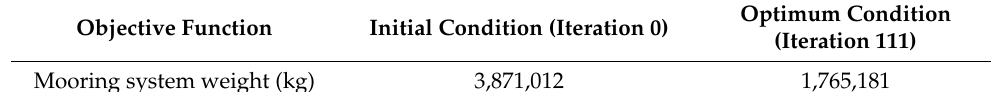
Table 13. Objective function results for case C.